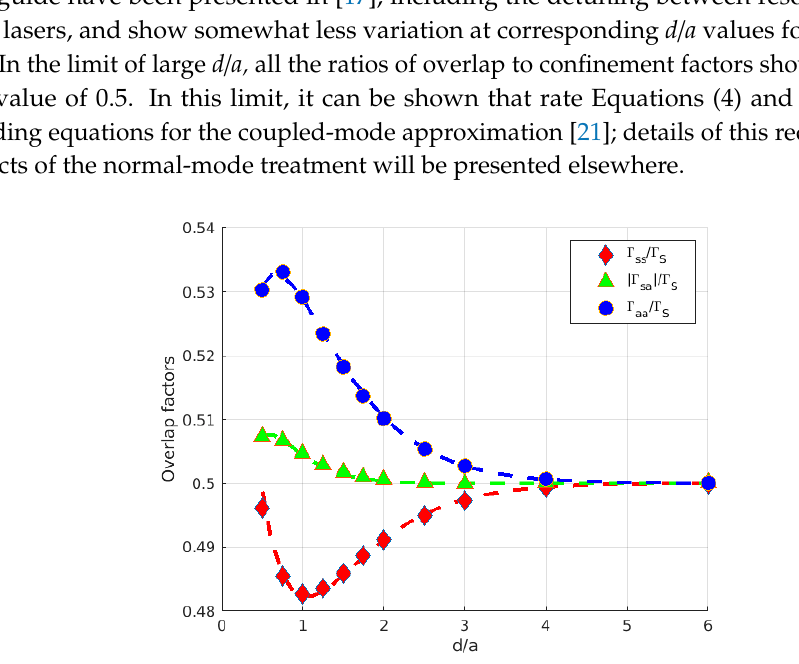
Figure 3. Overlap factors versus d / a for coupled circular cylindrical guides with v = 1.571.